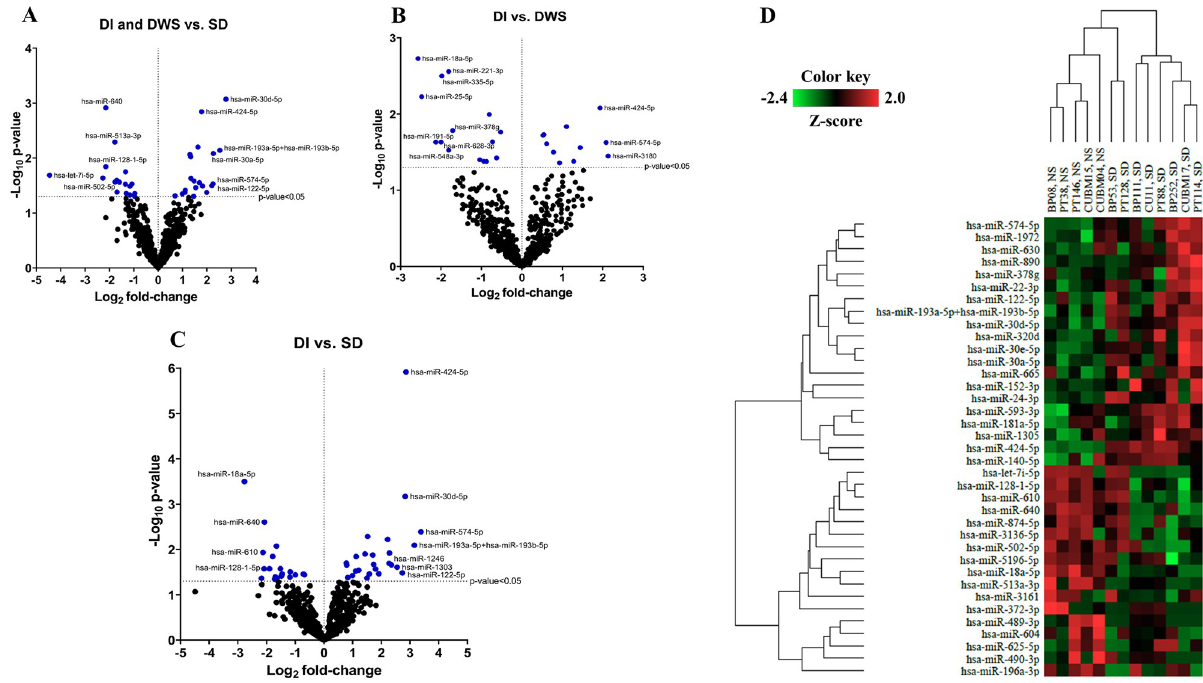
Fig 1. Circulating miRNA profiling of dengue-infected patients. A.Volcano plots showing changes in the expression levels of miRNAs between severe and non-severe groups. B.Volcano plots showing changes in the expression levels of miRNAs between DWS and DI groups. C.Volcano plots showing changes in the expression levels of miRNAs between SD and DI groups. D.The heatmap shows the 29 miRNAs dysregulated (Log 2 fold change > 1.5 and p -value < 0.05) in the SD groups when compared with the DI group. DI, dengue without warning sign; DWS, dengue with a warning sign; SD, severe